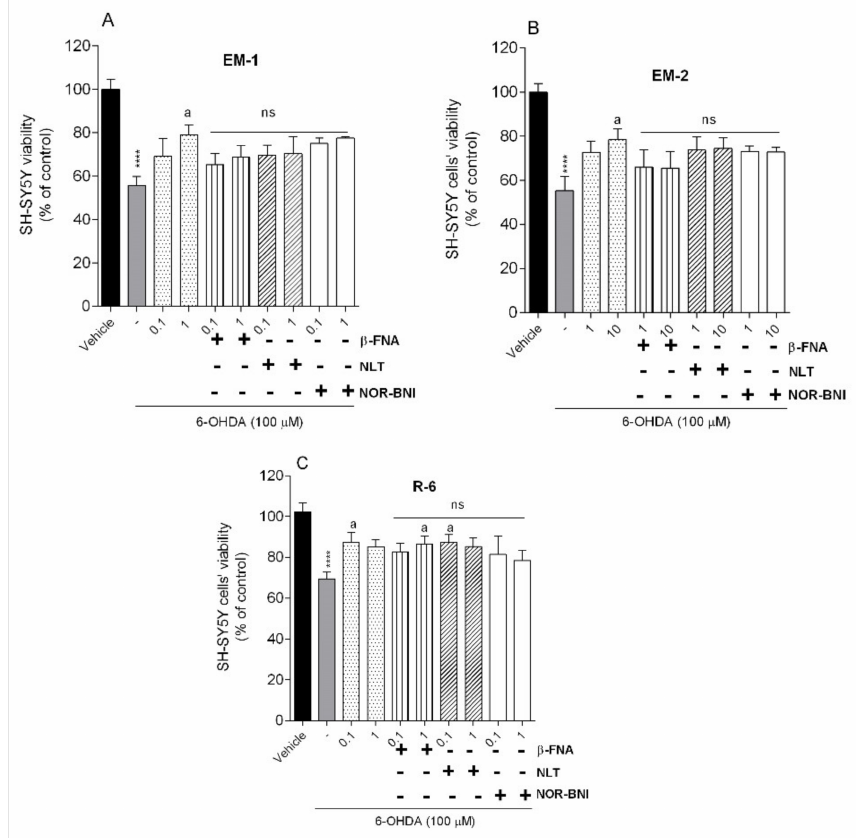
Figure 6. Neuroprotective effects on SH-SY5Y cells treated with 6-OHDA (100 µ M) in the presence of ( A ) EM-1, ( B ) EM-2, ( C ) R-6, respectively, and β -FNA ( µ -opioid receptor antagonist, 10 µ M), NLT ( δ -opioid receptor antagonist, 10 µ M), or NOR-BNI ( κ -opioid receptor, 10 µ M). The values in each column represent the mean ± SEM of 3 independent experiments. **** p < 0.0001, as compared